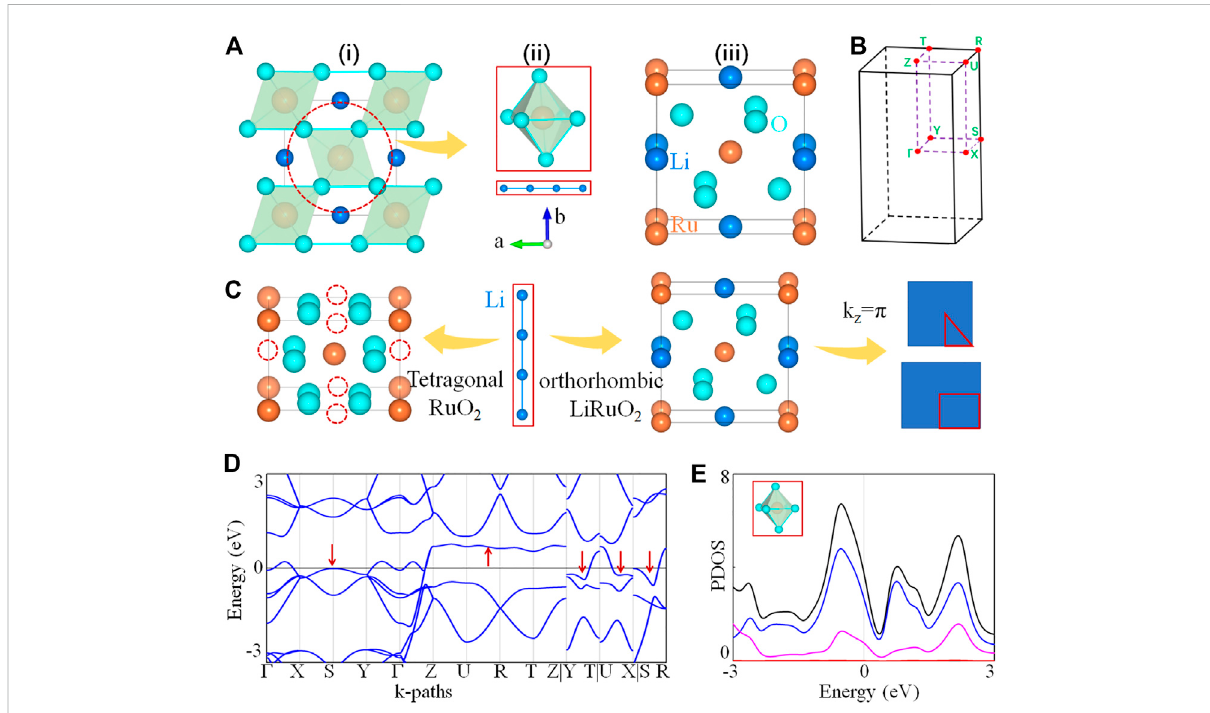
FIGURE 2 Crystal structure (A) and Brillouin zone (B) of LiRuO 2 . Among them, the primitive cell (iii) of LiRuO 2 is formed by countless O atoms with a tilted octahedron, Ruatoms with abody center, and Li atoms with a one-dimensional chain (ii). (C) Anode material RuO 2 with atetragonal structure forms the fi nal LiRuO 2 with an orthorhombicstructure byinserting lithium ions. The electronicband structure without SOC (D) and the density of states (E) of LiRuO 2 , where the arrows point the two-fold degenerate bands of all